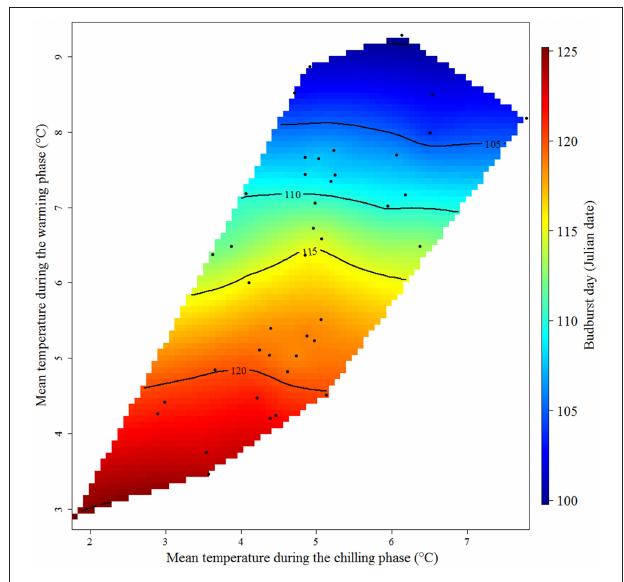
FIGURE 2 | Response of the budburst date of grapevine cv. ‘Riesling Italico’ in Mandicevac (Croatia) to average temperatures during the chilling and warming periods (September 23rd to February 27th and January 22nd to May 1st, respectively (historical data from 1961 to 2013). Colors and contour lines represent predicted flowering dates expressed in Julian dates (days of the year) using observed data points of grapevine budburst dates in Mandicevac (Croatia; black dots).